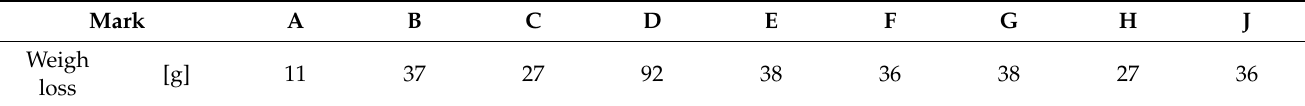
Table 5. Weight loss of selected toothed segments.